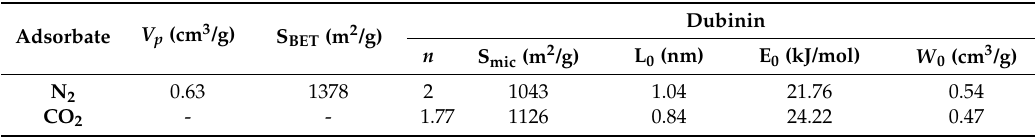
Table 2. Main textural characteristics of the produced CNS-activated